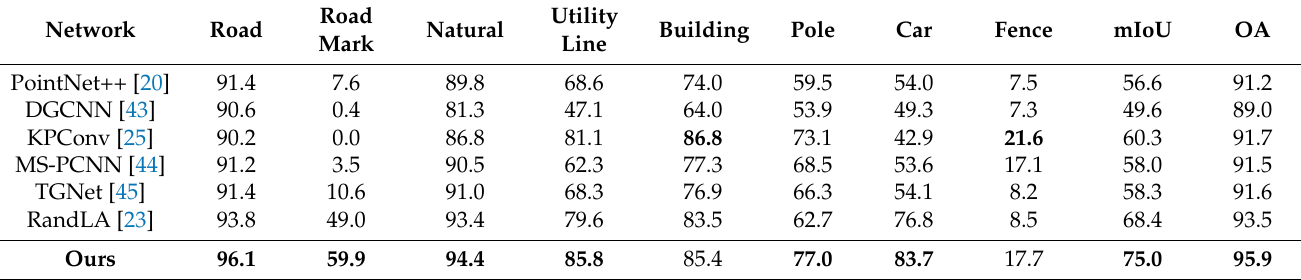
Toronto3D Dataset. We used the L001, L003, and L004 as the training set and the L002 as the test set. We compared our method with PointNet++ [20], DGCNN [43], KPConv [25], convolution acting on graphs. MS-PCNN uses dynamic point-wise convolutional opera- tions in multiple scales for point cloud segmentation. TGNet proposes a graph convolution function named TGConv to extract point features of neighbors. The results are shown in Table 5. Conclusions like in the CSPC Dataset can be drawn. Our method exceeded the second-best RandLA-Net 6.6% and the rest methods by at least 15% on mIoU. Compared with RandLA-Net, our method improved on three evaluation metrics, especially the IoU of road marking, pole, car, and fence improved over 10 percent. Table 5. The segmentation results evaluated on IoU of each category, mIoU, and OA of Toronto3D dataset. Utility Road Building Natural Network Road Line Mark